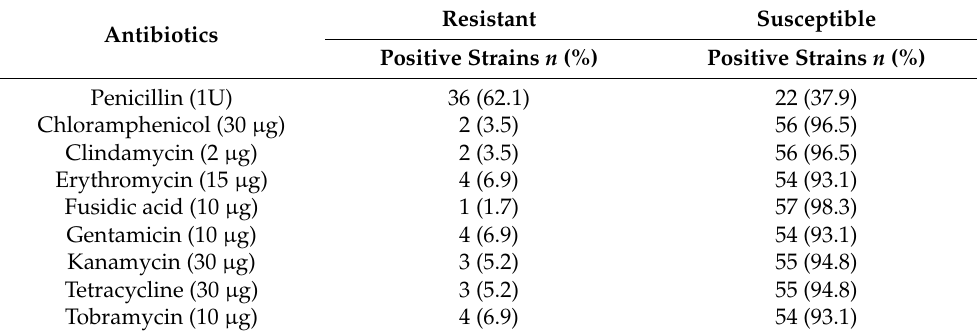
Table 1. Antimicrobial resistance of 58 positive isolates of S. aureus .